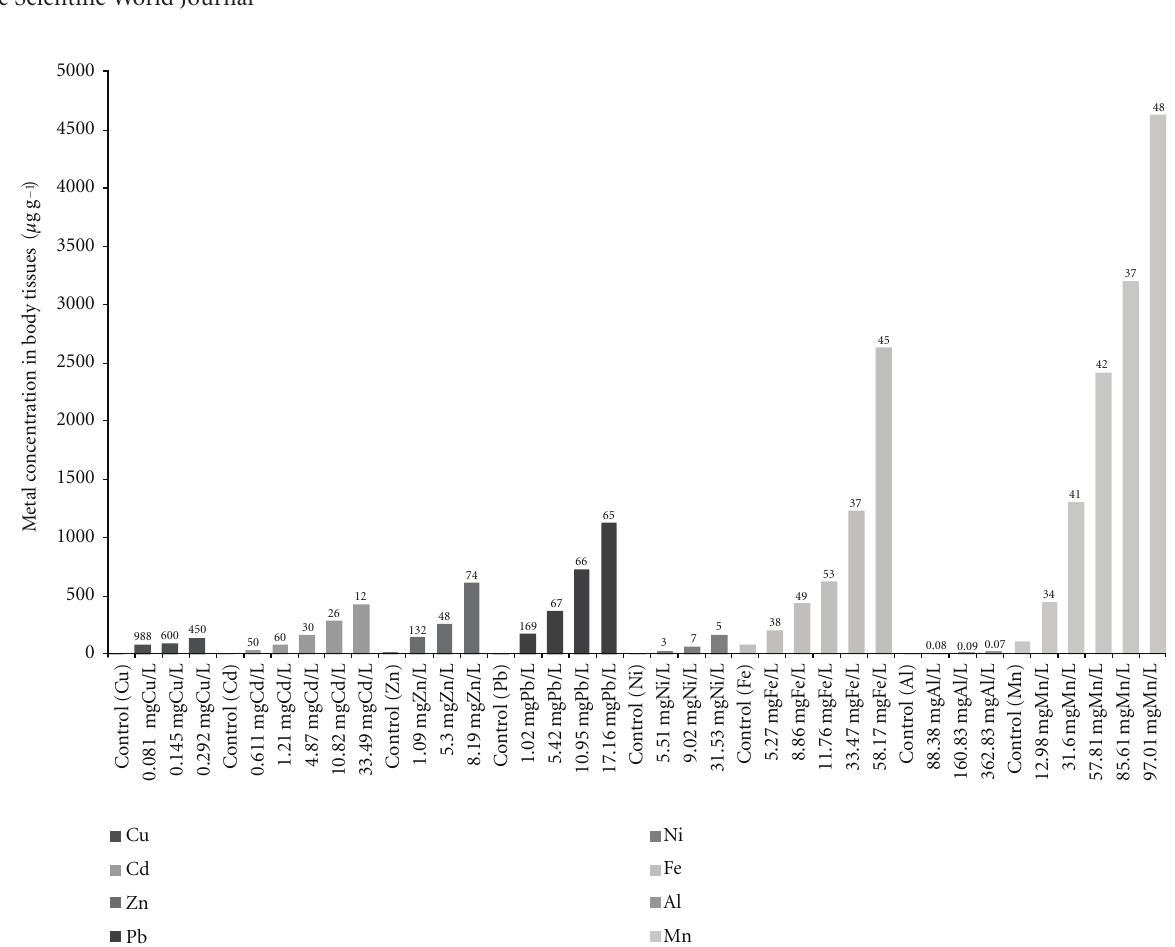
Figure 3: Bioconcentration of Cu, Cd, Zn, Pb, Ni, Fe, Al, and Mn (mean) in M. tuberculata soft tissues ( µ gg − 1 dry weight) after a four-day exposure to di ff erent concentrations of Cu, Cd, Zn, Pb, Ni, Fe, Al, and Mn. Concentration factor (CF) is indicated at the top of each bar. whole body Cu concentrations of juvenile snails ( P. paludosa ) increased with exposure time and concentration and